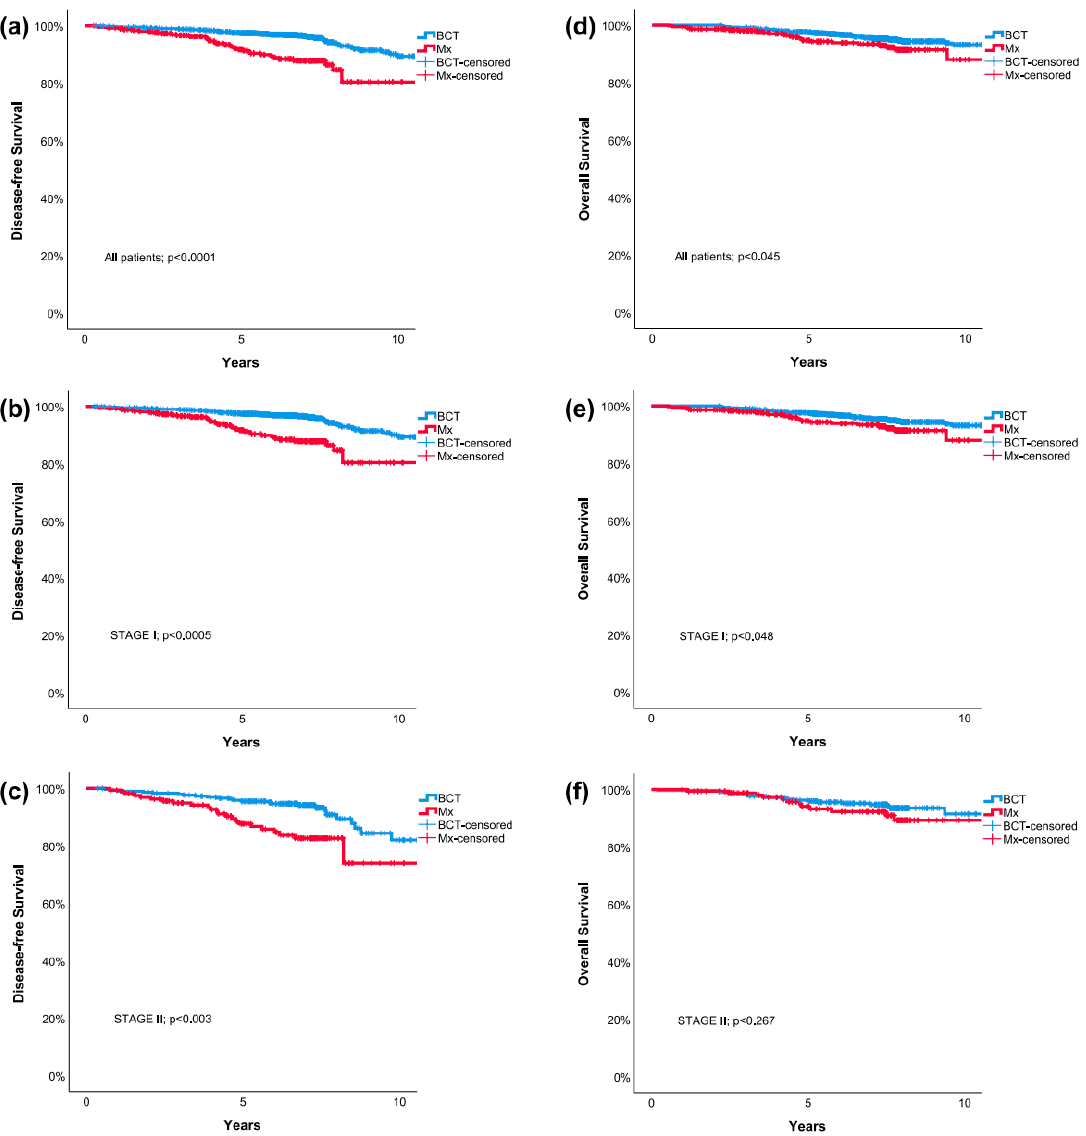
Figure 1. Kaplan–Meier survival curves comparing breast conserving therapy and mastectomy: Disease-Free Survival for all included patients ( a ), patients with stage I ( b ) and stage II ( c ) breast cancer; Overall Survival for all included patients ( d ), patients with stage I ( e ) and stage II ( f ) breast cancer. BCT = breast-conserving therapy; Mx = mastectomy.